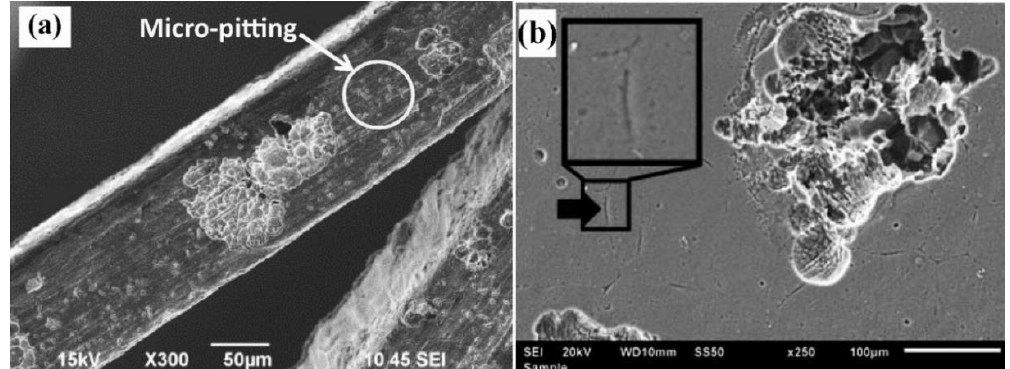
Figure 22. Pitting corrosion. ( a ) An oxidized tubing Nitinol stent after six months implantation into the iliac artery of a minipig [283]. ( b ) A Mg–Y–Ca–Zr WX11 alloy in the as-cast condition following potentiodynamic polarization test in DMEM with 10% FBS at 37 °C and cleaning with CrO 3 /AgNO 3 solution [284]. (b) also shows corrosion at prone grain boundary regions (arrow). Reprinted with permission from Elsevier.